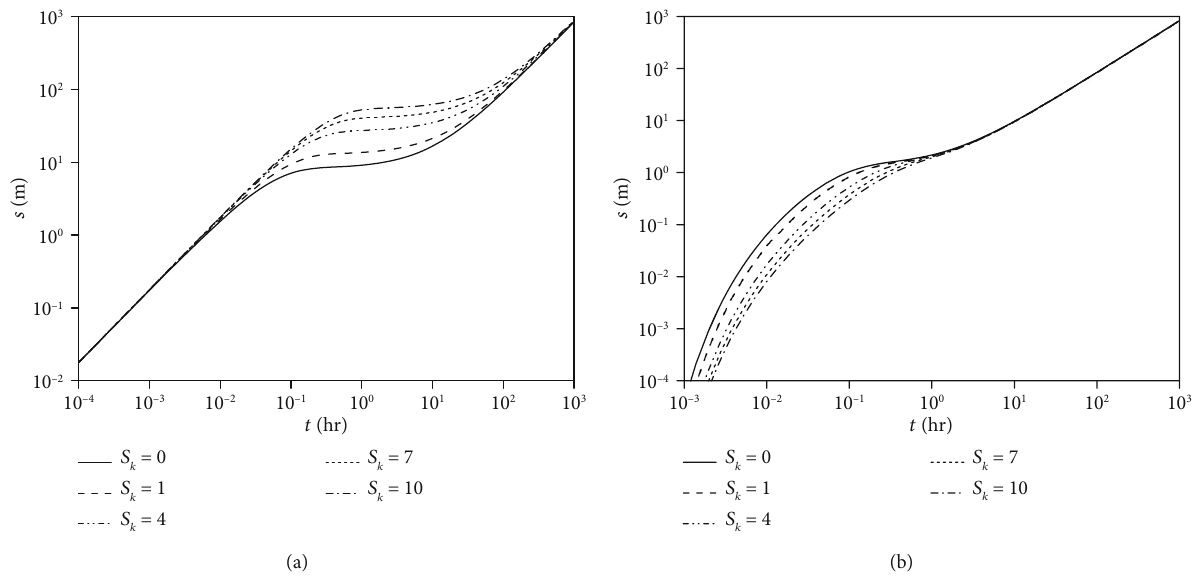
Figure 7: Impact of skin factor on the drawdown in pumping well (a) and aquifer